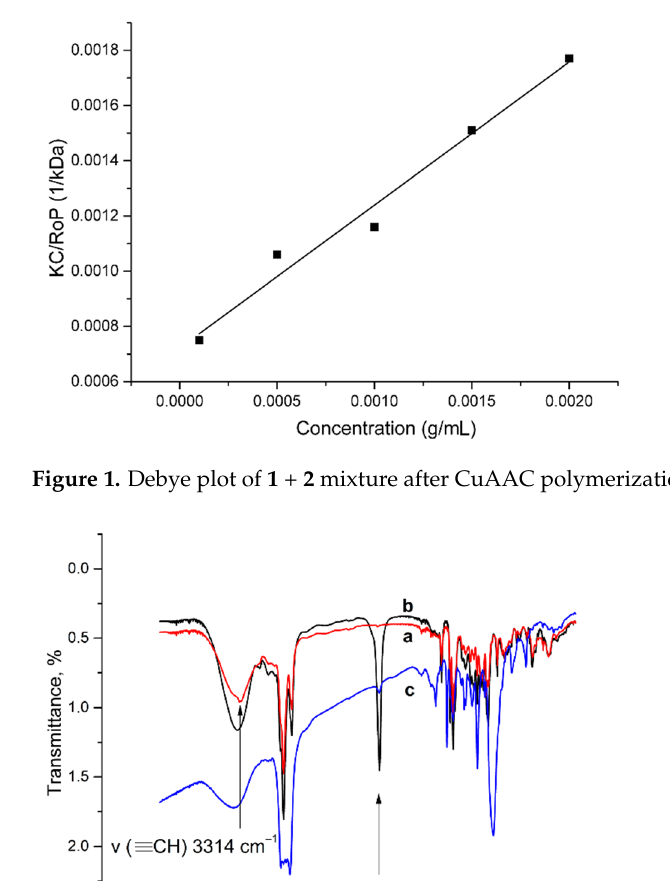
Figure 1. Debye plot of 1 + 2 mixture after CuAAC polymerization (0.01–2 mg/mL).